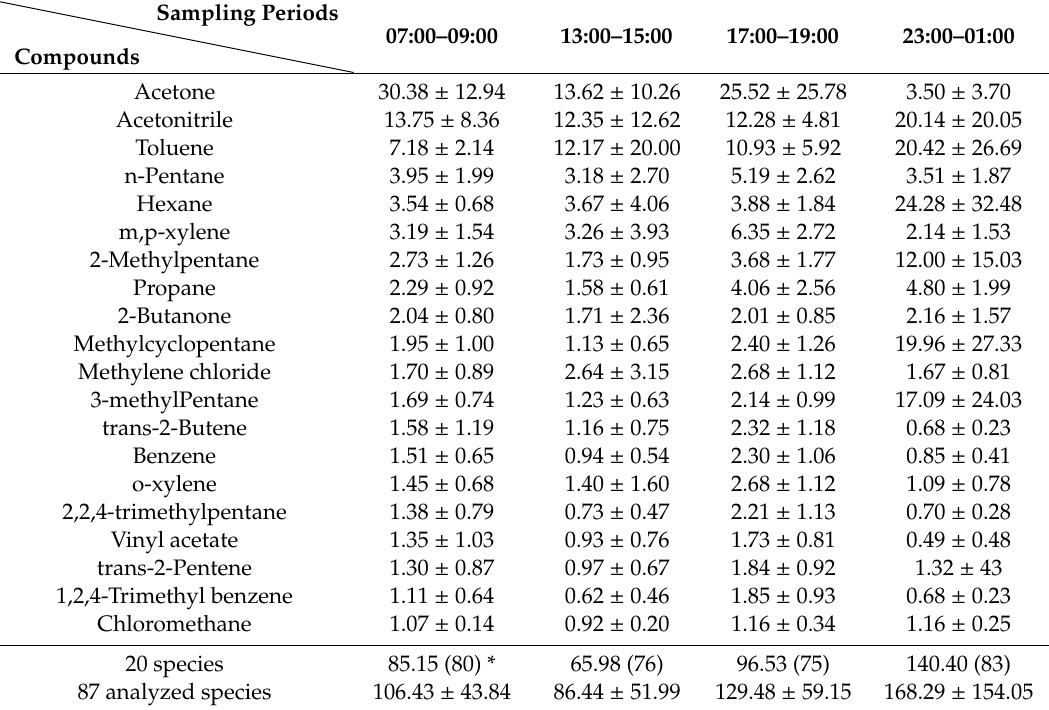
Table 2. VOC concentrations (ppbv) at residential